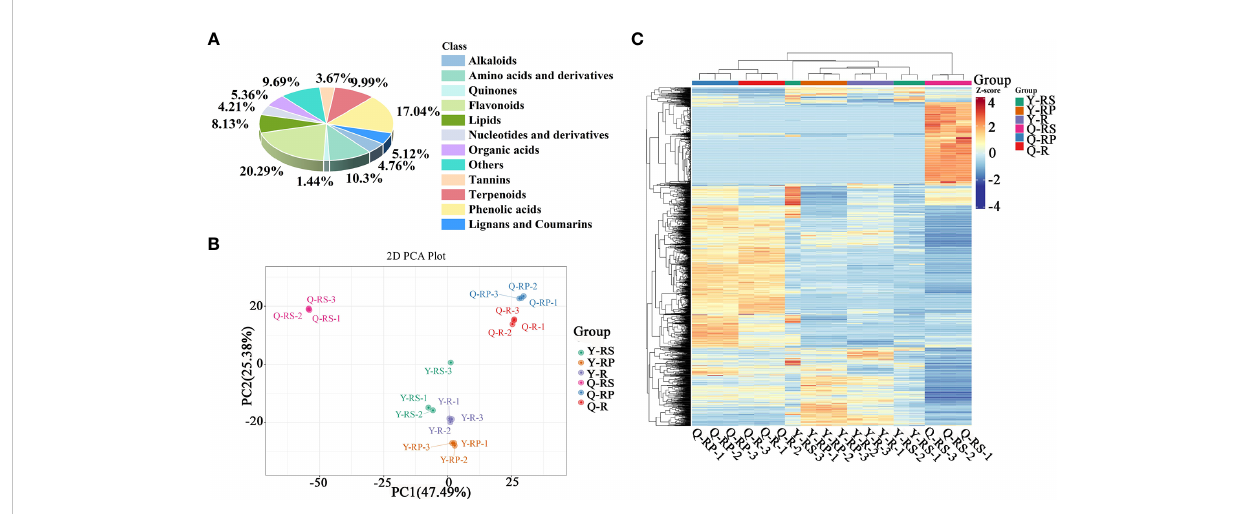
FIGURE 1 Overview analysis of widely-targeted metabolomics of different plateau raspberries. Classi fi cations of these metabolites identi fi ed based on the mass-to-charge ratio of the compounds in Metware database (A) ; PCA analysis (B) ; hierarchical cluster analysis (C)